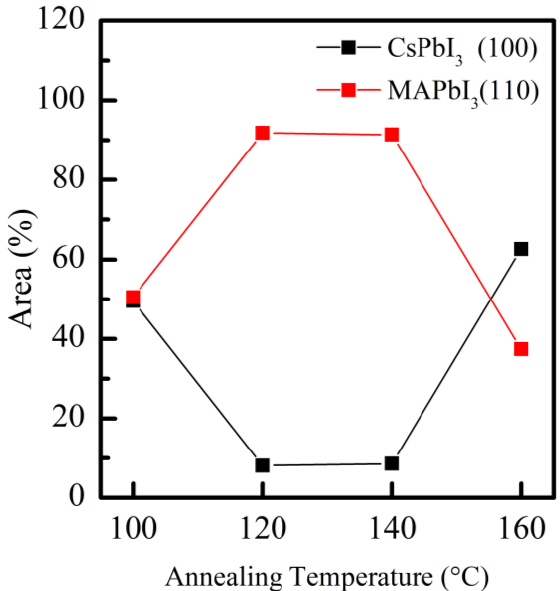
Figure 6. Area of PQD films at different annealing temperatures.